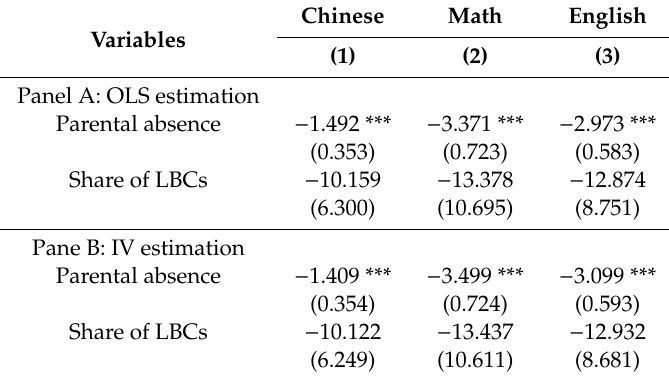
Table 6. E ff ects of parental absence on test scores of di ff erent subjects.